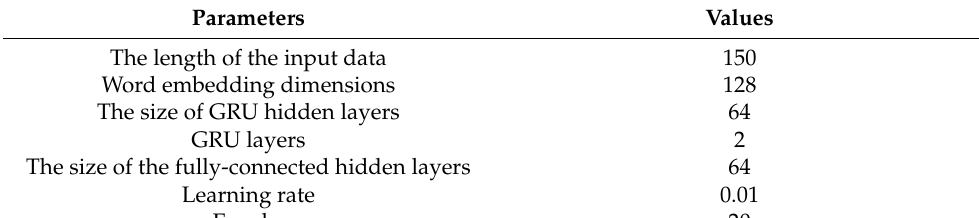
Table 5. Hyperparameters’ setting of the training model.